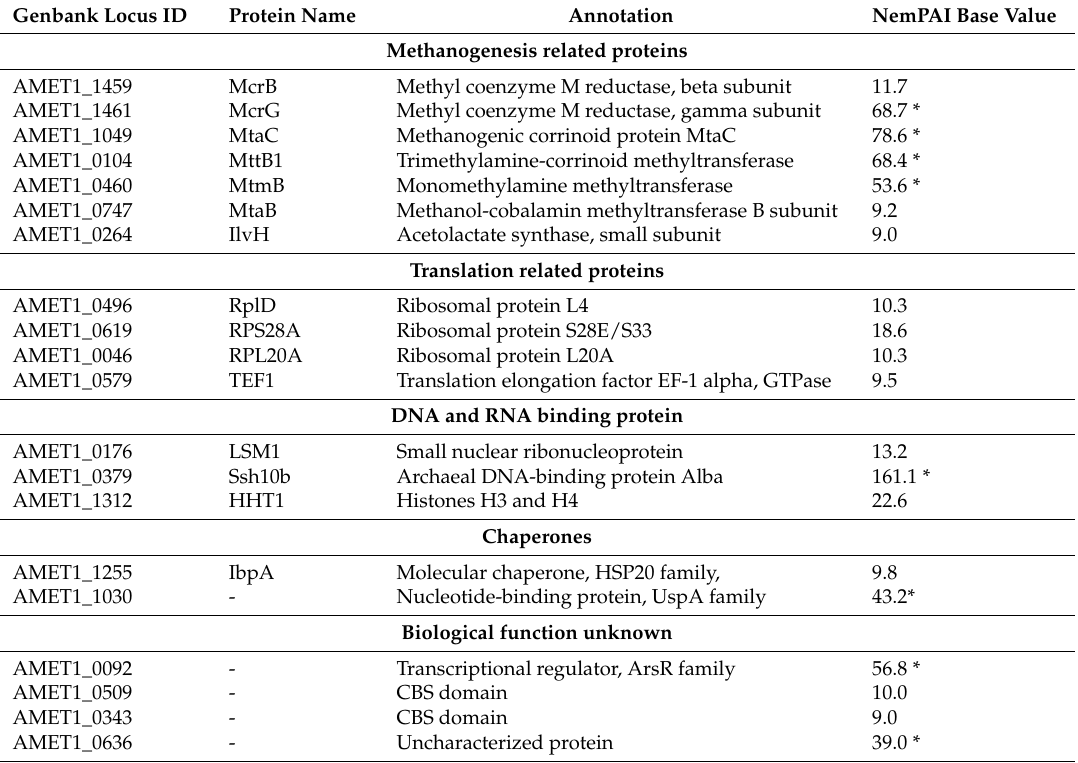
Table 1. Highly abundant proteins under optimal growth conditions in Methanonatronarchaeum thermophilum